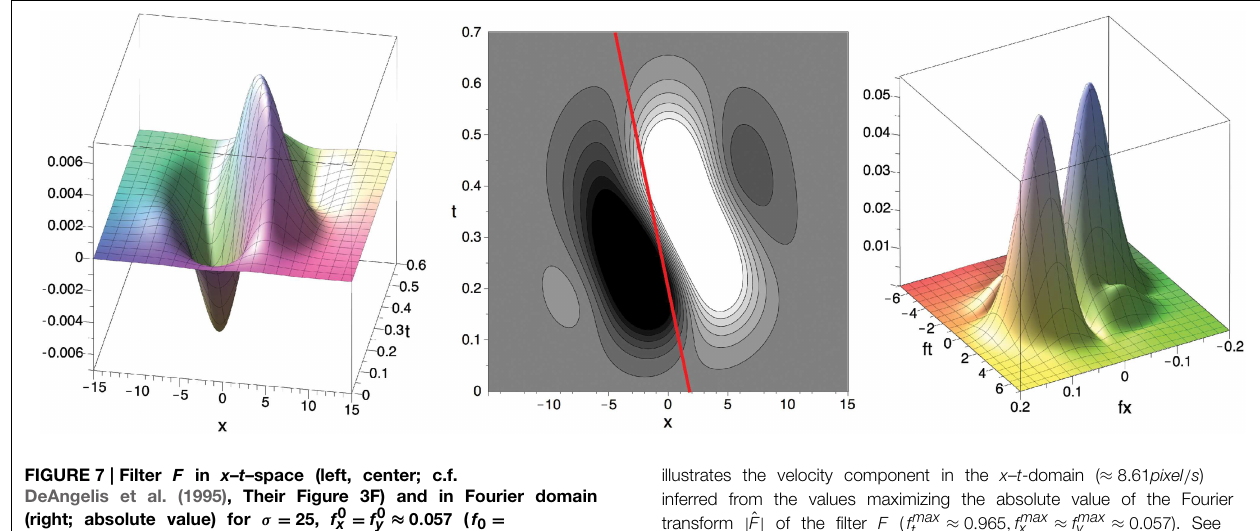
illustrates the velocity component in the x – t -domain ( 8 . 61 pixel / s ) ≈ inferred from the values maximizing the absolute value of the Fourier transform |ˆ F of the filter F ( f max t f max y 0 . 057 ). See 0 . 965 , f max x ≈ ≈ ≈ | text for